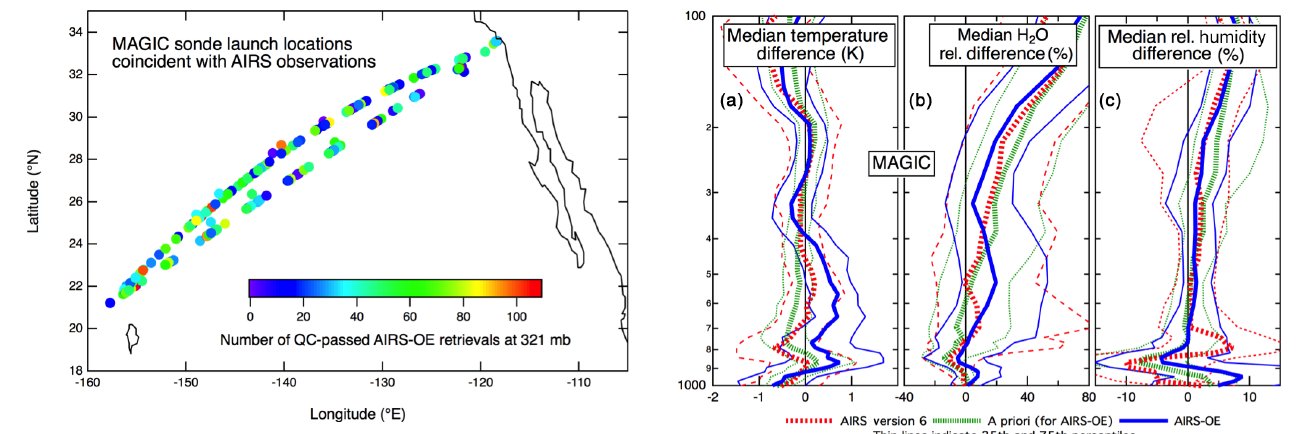
Figure 14. AIRS-OE, AIRS version 6 and a priori profile biases from MAGIC radiosondes. (a) Median temperature difference (mi- nus sonde). (b) Median relative difference in water vapor ([AIRS – sonde]/sonde in %). (c) Median difference in relative humidity (in %). Thin lines represent the 25th and 75th percentiles. AIRS obser- vations were within 3h and 100km of the sonde launch, and only those retrieval layers passing quality control were counted. In to- tal, 8633 AIRS profiles were matched to 210 sonde profiles. See Sect. 5.1 for description of data aggregation before calculation of